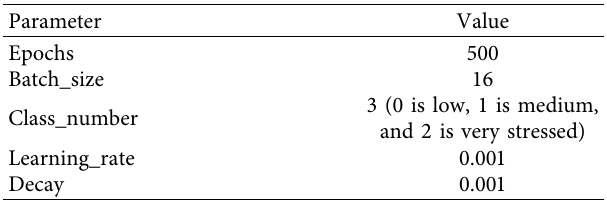
Table 7: Parameter settings.